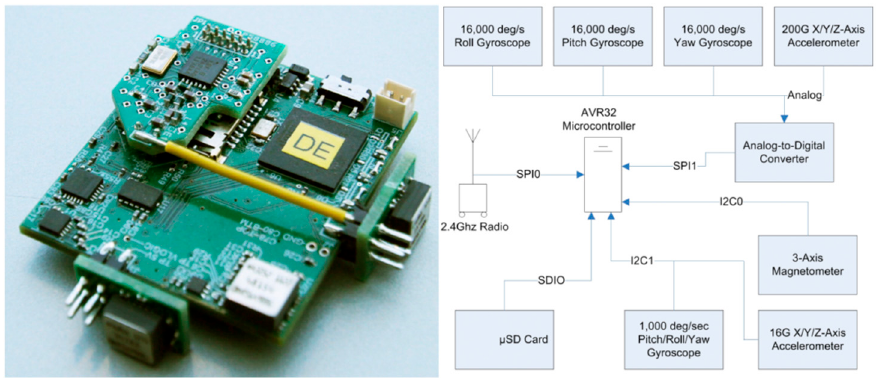
Figure 2. Final Wearable ‘Sportsemble’ Sensor Node ( left ) and Block Diagram ( right ).